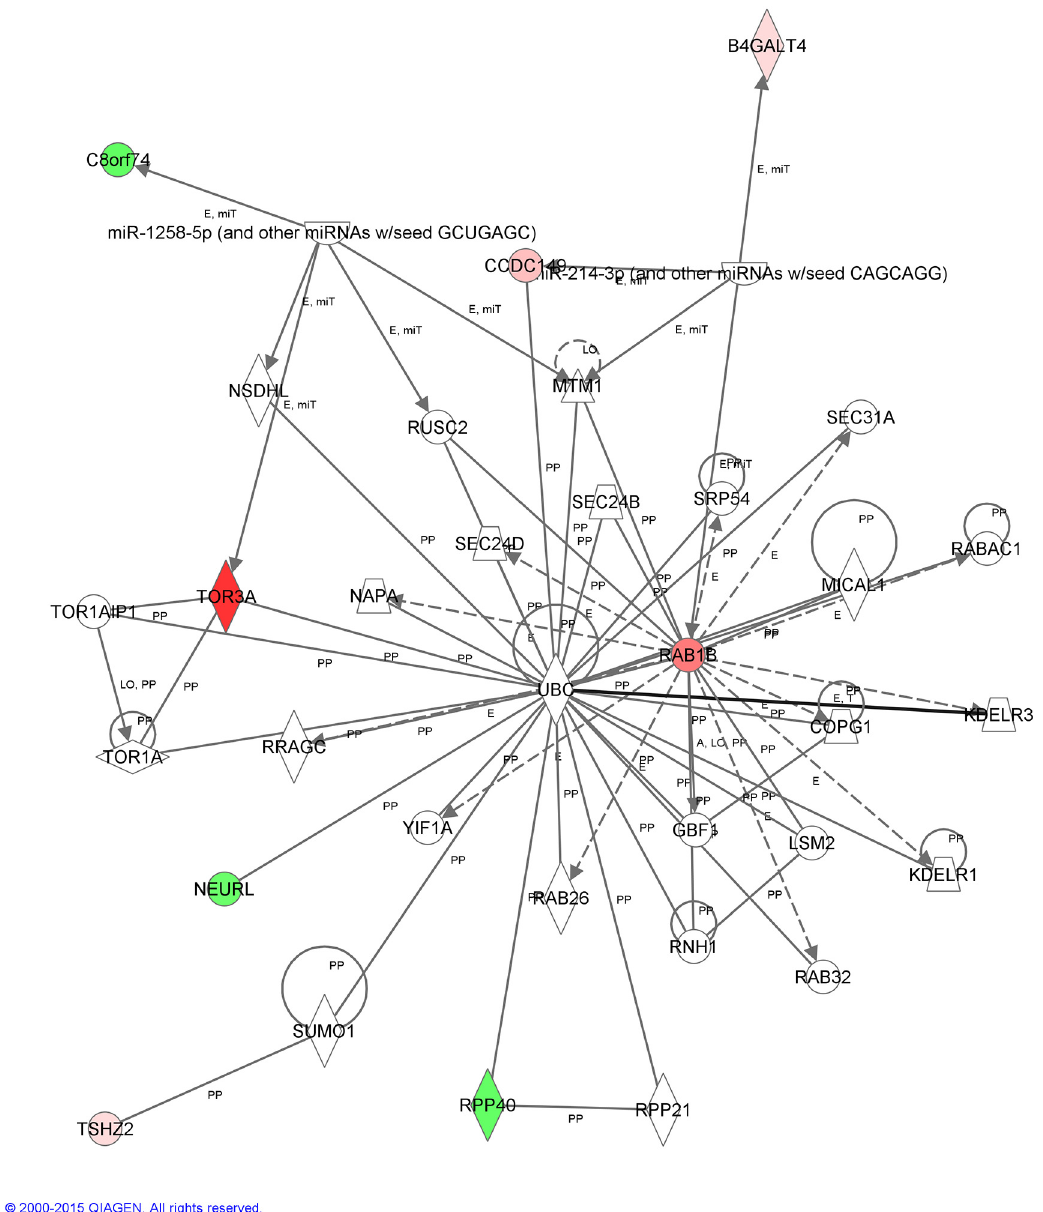
Fig 4. Interactome of functional associations among genes included in Network 2 by Ingenuity Pathway